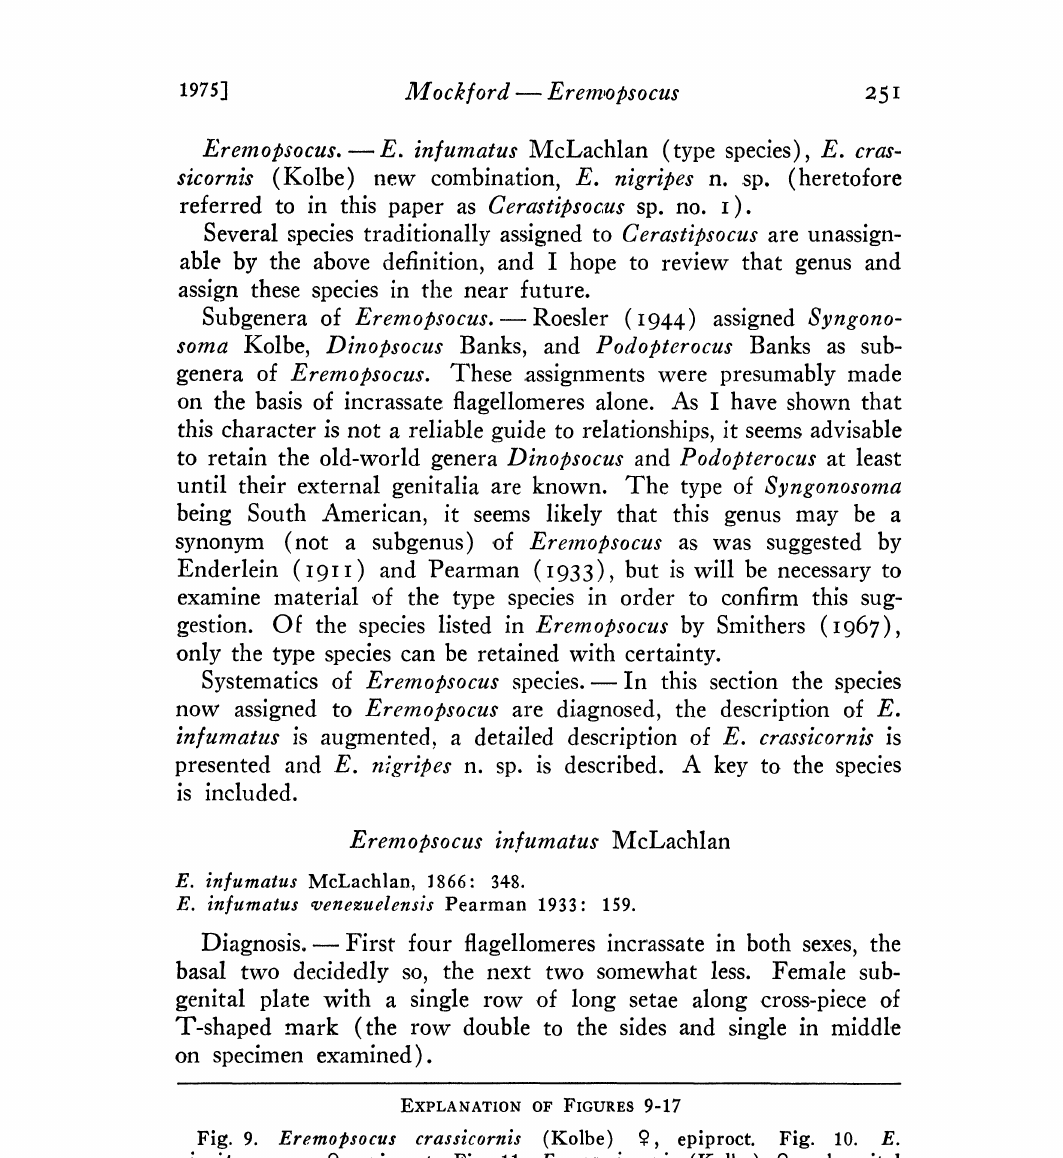
Fig. 9. Eremo2socus crassicornis (Kolbe) Q, epiproct. Fig. 10. E. , hi,Tripes n. sp. Q, epiproct. Fig. 11. E. crassicornis (Kolbe) Q, subgenital plate, scale of Fig. 12. Fig. 12. E. niTriles n. sp. Q, subgenital plate. gonapophyses. Fig. 14. E. nigrites Fig. 13. E. crasslcornis (Kolbe) n. sp. ?, gonapophyses, scale of Fig. 9. Fig. 15. E. infumatus McLachlan .q, epiproct, scale of Fig. 9. Fig. 16. E. crassicornis (Kolbe) ?, sperma- pore sclerite. Fig. 17. E. niari#es n. sp. ?, spermapore sclerite, scale of Fig.